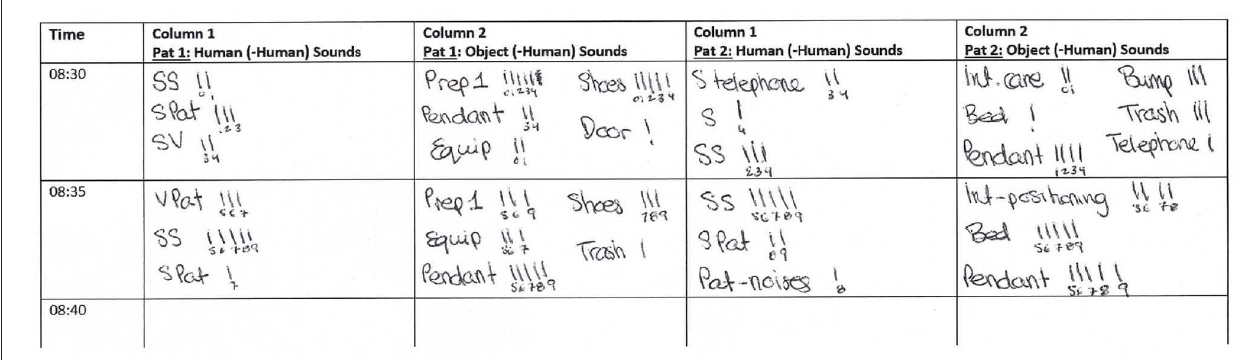
FIGURE 2 | Example observer sheet showing how two beds would be documented. The two columns on the left represent bed 1, and the two columns on the right represent bed 2. For each bed, the left column is where human (-human) sounds such as talking should be listed. For each bed, the right column is where object (-human) sounds should be noted such as sounds coming from the equipment, medical pendant, or shoes. Staff (S); staff-staff (SS); staff-patient (SPat); staff-visitor (SV); visitor-patient (VPat); preparation board one (Prep1); equipment (Equip); patient-noises (Pat-noises); intervention (Int). Full list of abbreviations, sound sources, and descriptions can be found in the Supplementary Table 1